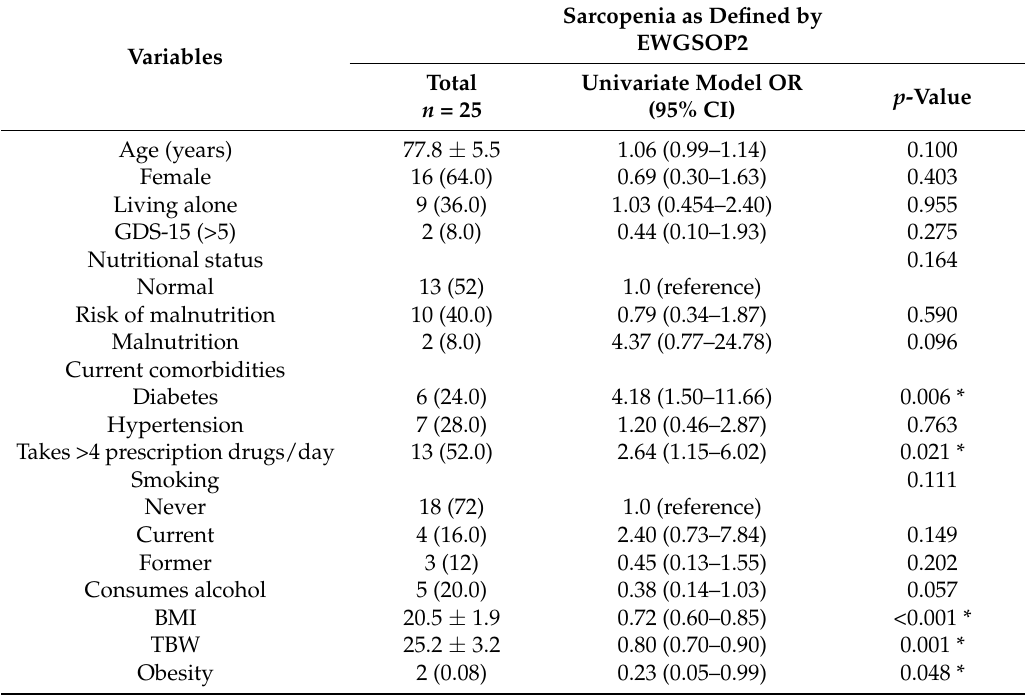
Figure 2. The prevalence of sarcopenia for each sex and each age group. Table 2. Univariate logistic regression of the potentially associated risk factors for sarcopenia.